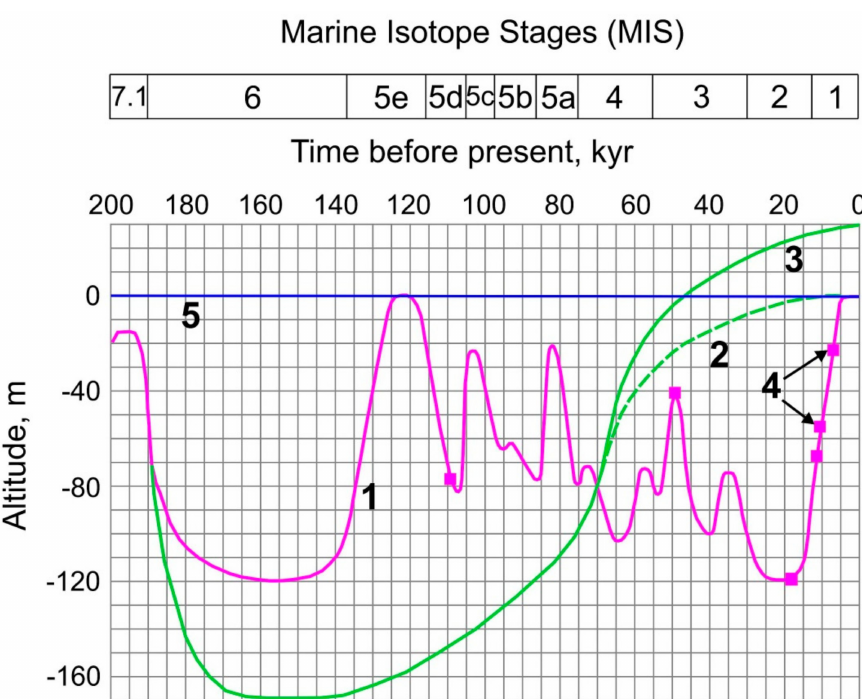
Figure 5. Regional fluctuations of sea level (purple line 1) and glacioisostatic movements of the ground surface at the southern (dashed green line 2) and northern (solid green line 3) parts of the study area. Purple dots 4—dated sea level benchmarks [62–66]; blue line 5—recent sea